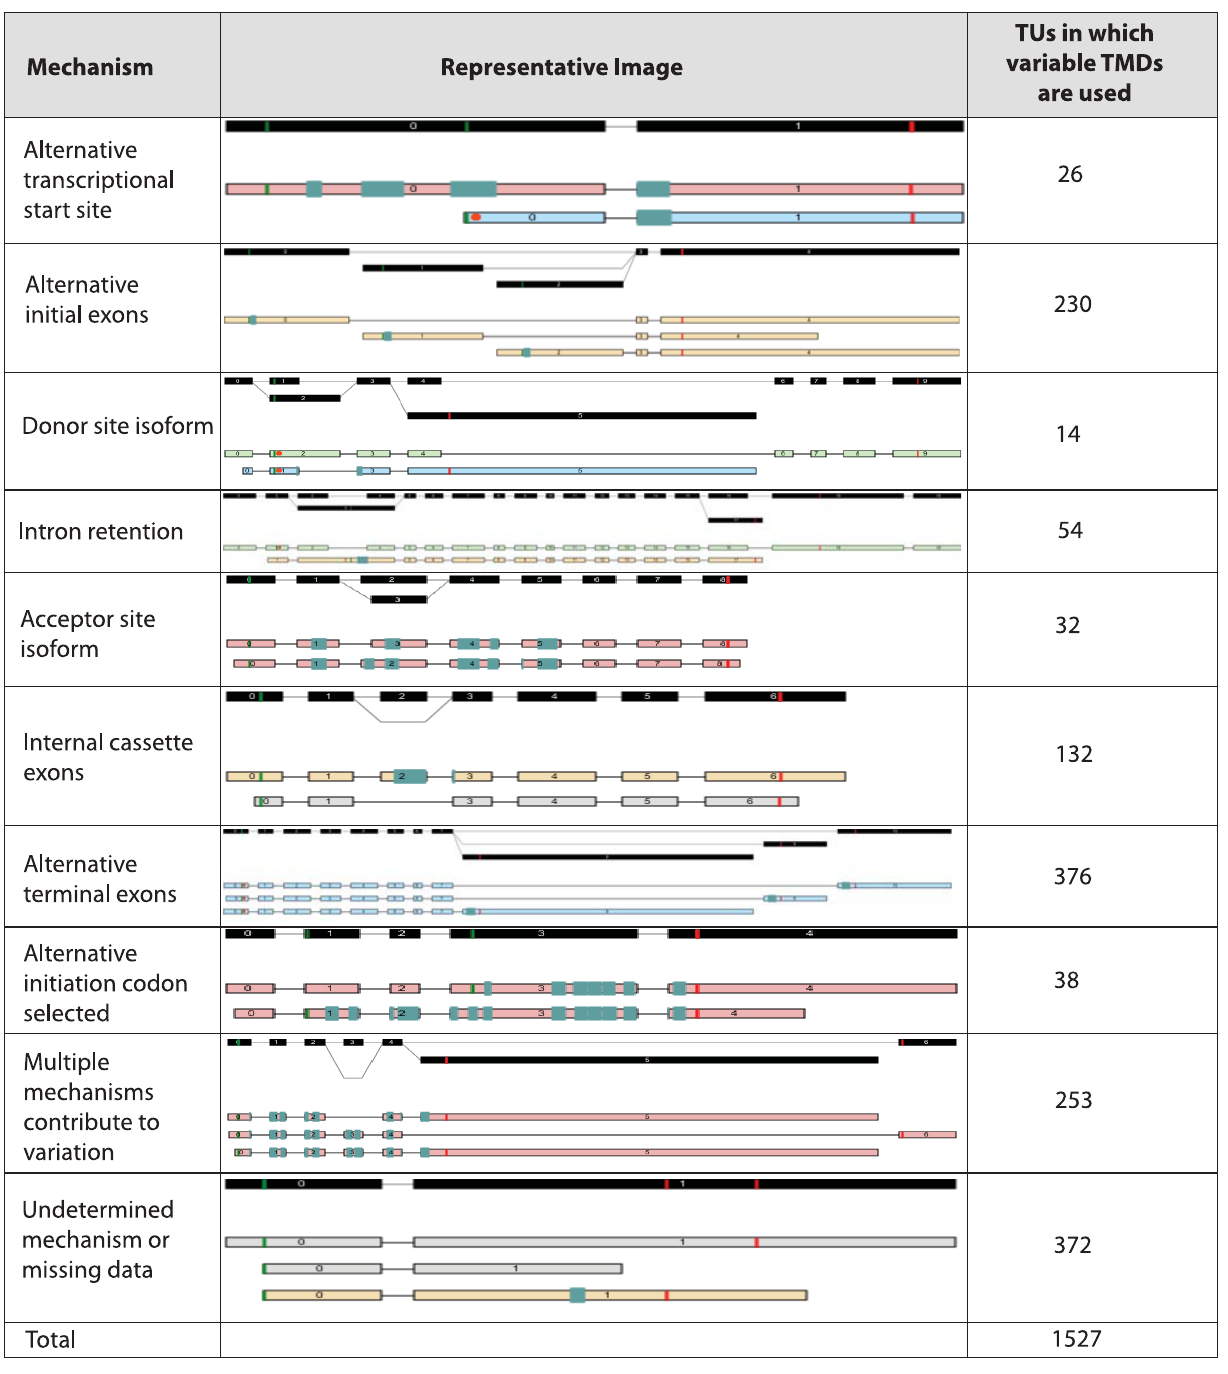
Figure 2. Variation of TMDs by Transcript Variation and Alternative Splicing DOI: